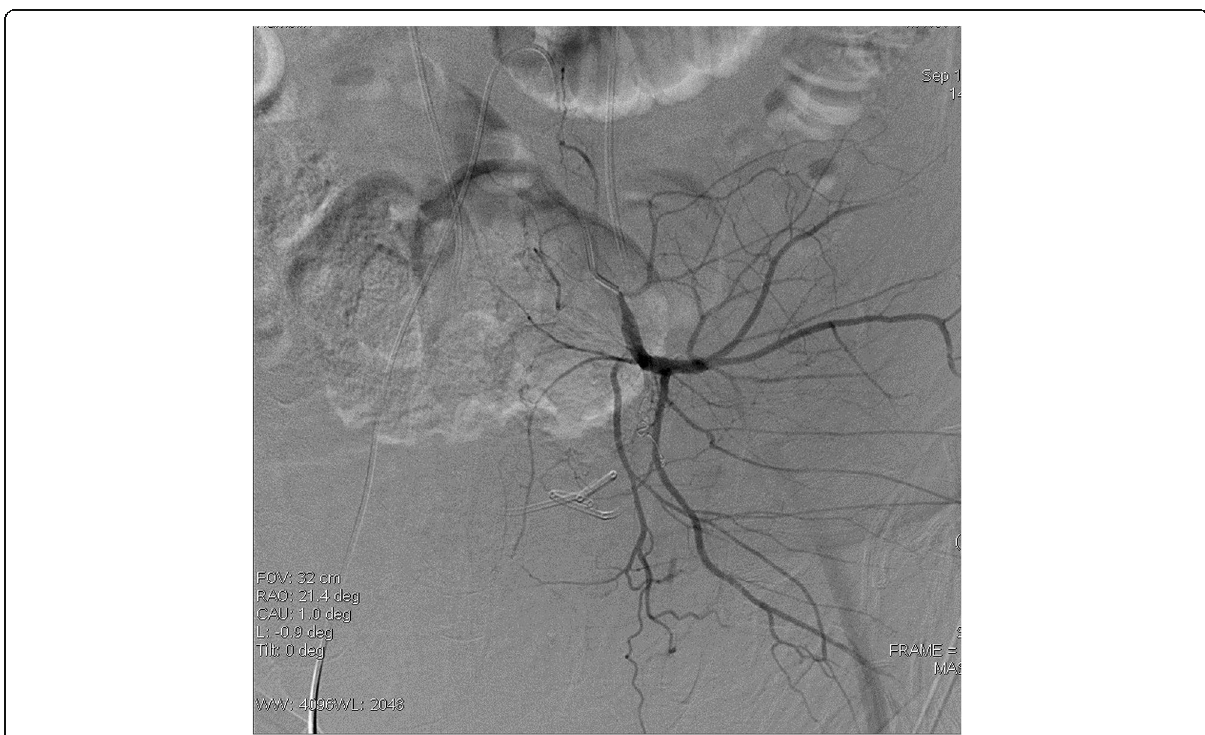
Fig. 2 Angiography after coil embolization demonstrated non opacification of the pseudoaneurysm and absence of extravasation